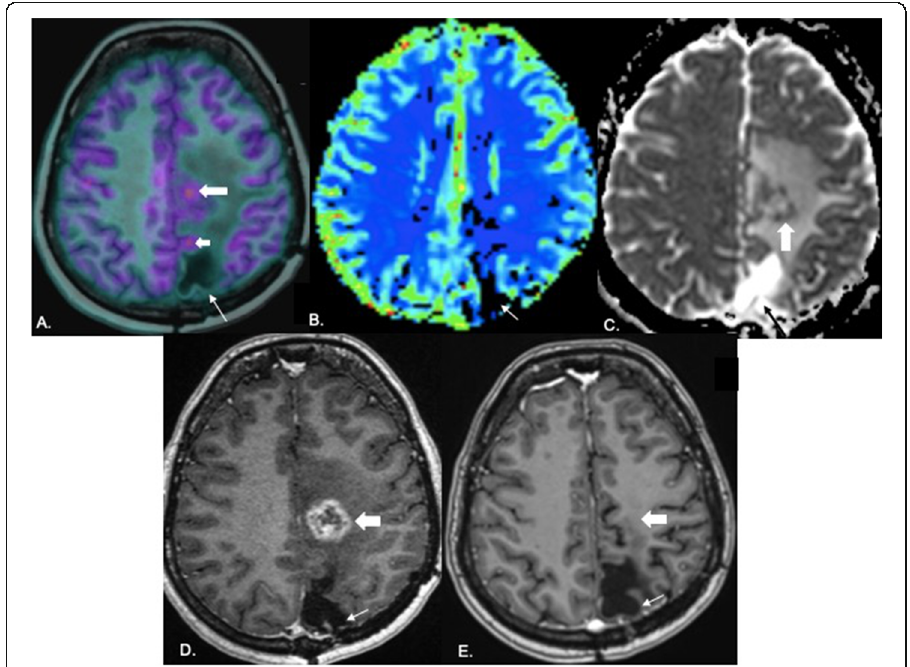
Fig. 7 False positive diagnosis on PET: 34-year-old female diagnosed with anaplastic ODG 2 years back with enhancing lesion on MRI. PET image fused with axial T1 MPRAGE ( A ) shows an area of uptake along the parasagittal region of the left frontal lobe (large thick arrow) and another area (small thick arrow) along the margin of the resection cavity (linear white arrow) raising a suspicion of recurrence. There is no evidence of elevated perfusion on the rCBV map ( B ). Resection cavity is shown by white arrow. Peripheral diffusion restriction is seen along the margins of the lesion in the left centrum semiovale (block white arrow in C ). There is no restriction along the resection cavity (black arrow). Peripheral enhancement is seen along the margins of the lesion in the left centrum semiovale (block white arrow in D ) with no enhancement along the resection cavity (white arrow). One month follow-up axial post-contrast T1 MPRAGE ( E ) shows the resection cavity (thin white arrow) with complete resolution of enhancement in the left centrum semiovale (block white arrow) suggestive of treatment related changes excluding